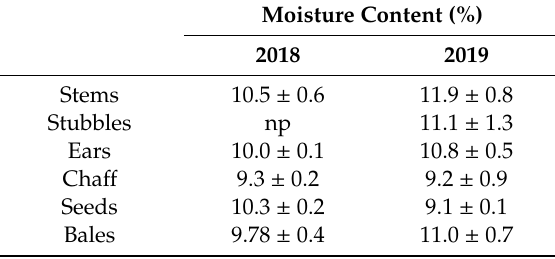
Table 8. Moisture content in bales and in di ff erent fractions of the wheat.